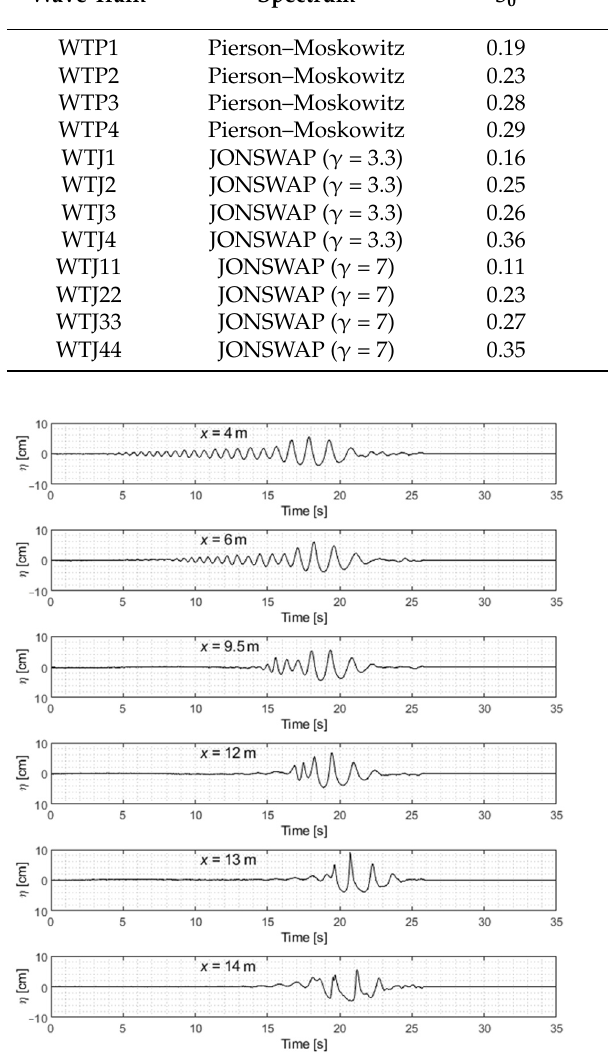
Table 1. Wave train key parameters. γ is the peak enhancement factor. It is the ratio of the maximum spectral energy to the maximum of the corresponding Pierson–Moskowitz spectrum. The lower value γ = 3.3 corresponds to the standard JONSWAP formulation, and γ = 7 provides a narrower spectrum. Wave Train Spectrum